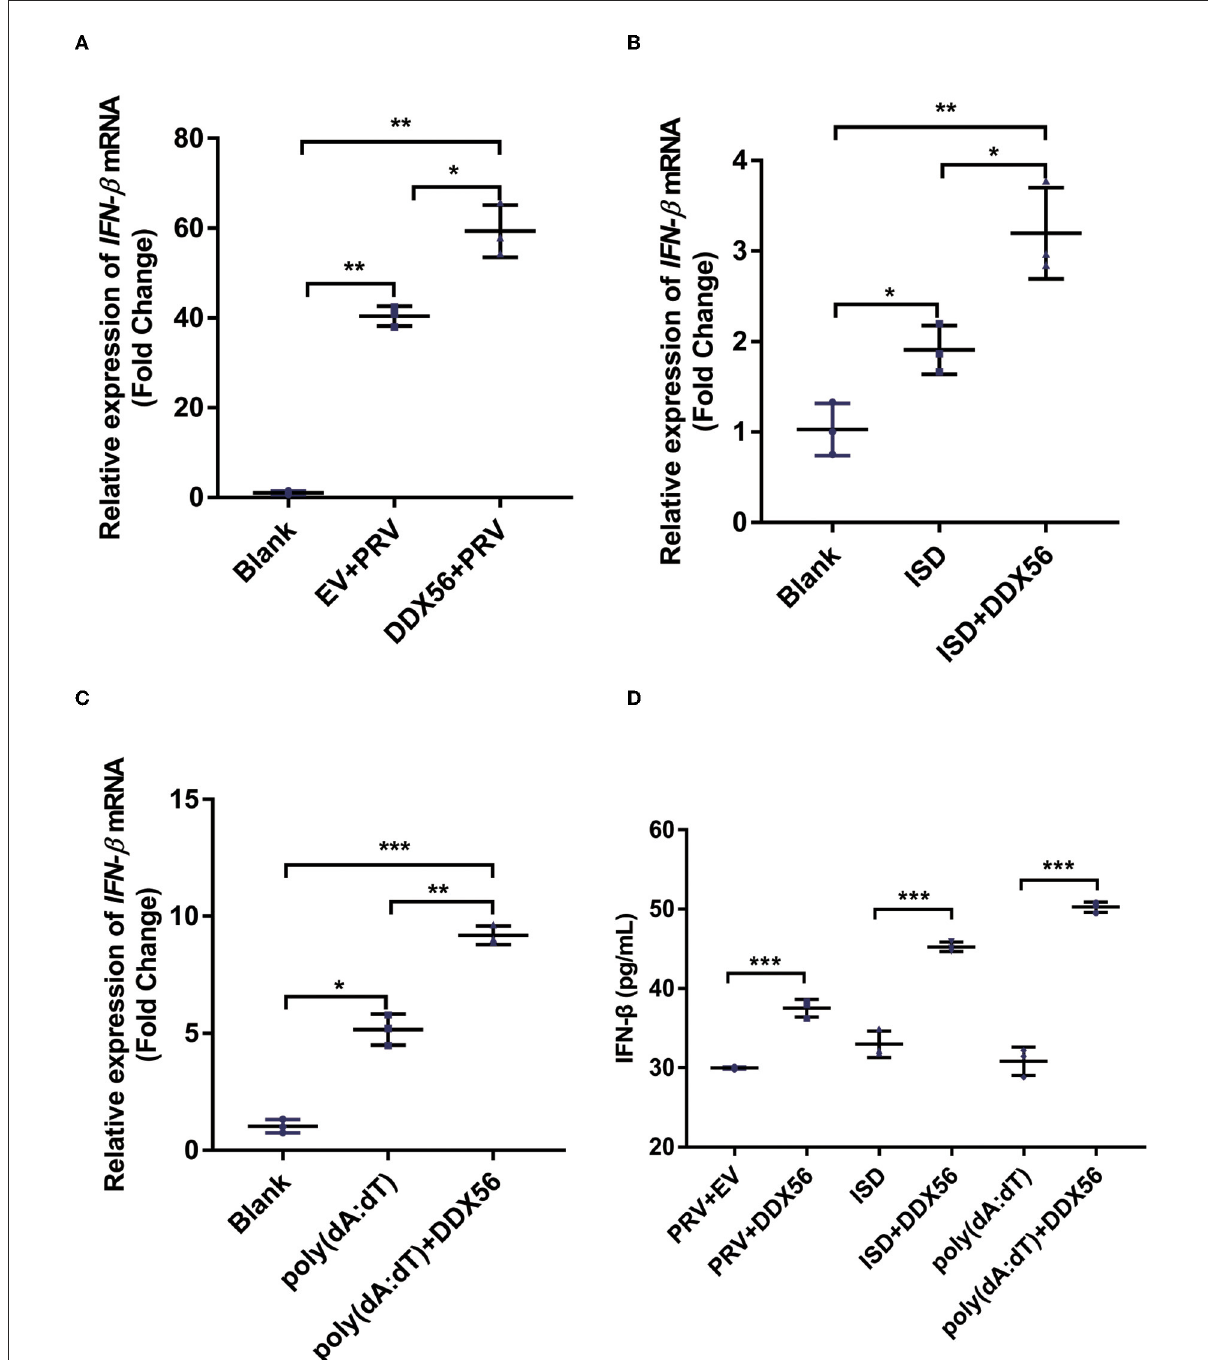
FIGURE3 DDX56 promotes IFN- β expression. (A) Empty vector (EV, 1 µ g) or pCMV-Myc-DDX56 (1 µ g) plasmid was transfected into PK15 cells for 24 h, then followed by infection with 100 TCID 50 PRV for another 24h. Cells were collected for RNA extraction. RT-qPCR was used for detecting IFN- β mRNA. Data were presented as means ± SD of three independent experiments, measured in technical duplicates. ** p < 0.01, * p < 0.05. (B) Empty vector (EV, 1 µ g) or pCMV-Myc-DDX56[[Inline Image]] (1 µ g) plasmid was transfected into PK15 cells for 24h, then stimulated with 1 µ g ISD for another 12h. Cells were collected for RNA extraction. RT-qPCR was used for IFN- β mRNA detection. Data were presented as means ± SD of three independent experiments, measured in technical duplicates. ** p < 0.01, * p < 0.05. (C) Empty vector (EV, 1 µ g) or pCMV-Myc-DDX56 (1 µ g) plasmid was transfected for 24h, then stimulated with 1 µ g poly(dA:dT) for another 12h. Cells were collected for RNA extraction. RT-qPCR was used for IFN- β mRNA detection. (D) IFN- β concentration in cell culture supernatant was detected by ELISA. Data were presented as mean ± SD of three independent experiments, measured in technical duplicates. *** p < 0.001; ** p < 0.01, * p <